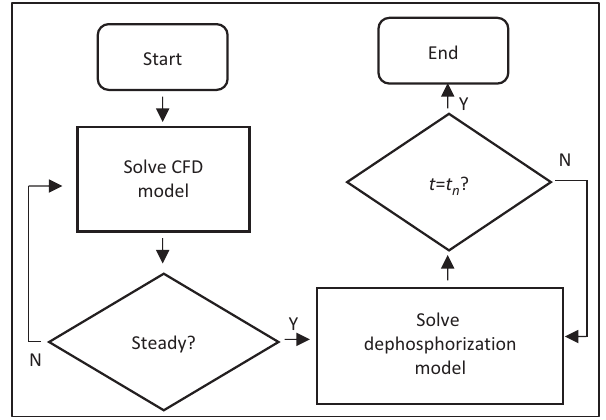
Figure 2: Flow sheet of coupling dephosphorization kinetics and CFD model.